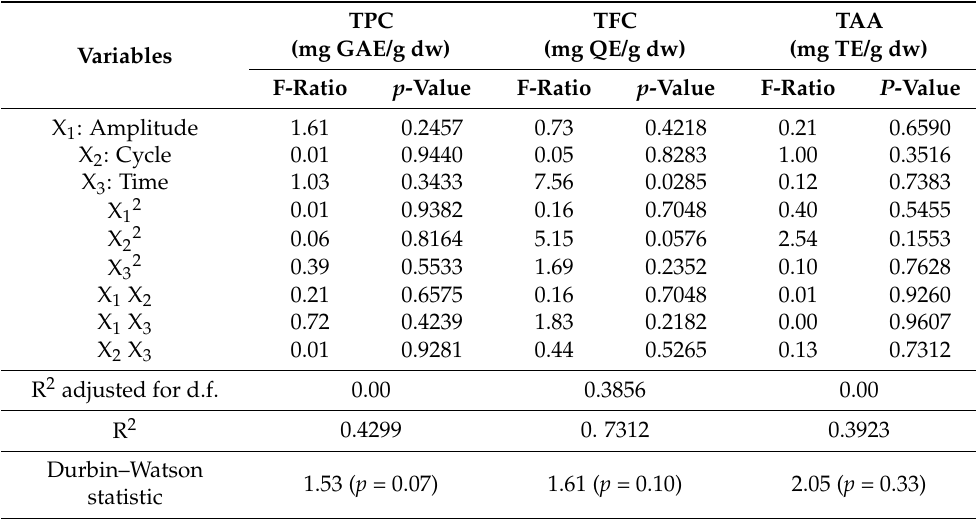
Table 4. F-test ratio, coefficient of regression R 2 , Durbin-Watson statistic and p -values of the predicted model for TPC, TFC, and TAA from cornelian cherry ultrasound-assisted extraction. TPC TFC (mg GAE/g dw) (mg QE/g dw) Variables